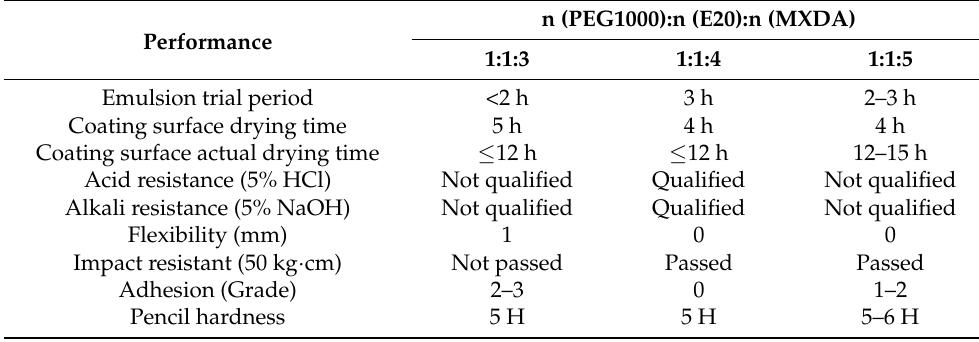
Table 4. Effect of molar ratio of PEG1000, E20, and MXDA on the curing agent and the cured film performance.